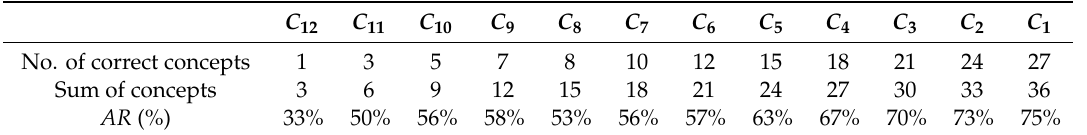
Table 2. Learning achievement results for student 1, who correctly answered Q 1 – Q 17 , Q 19 – Q 20 , Q 24 – Q 26 , Q 29 – Q 32 , and Q 36 .